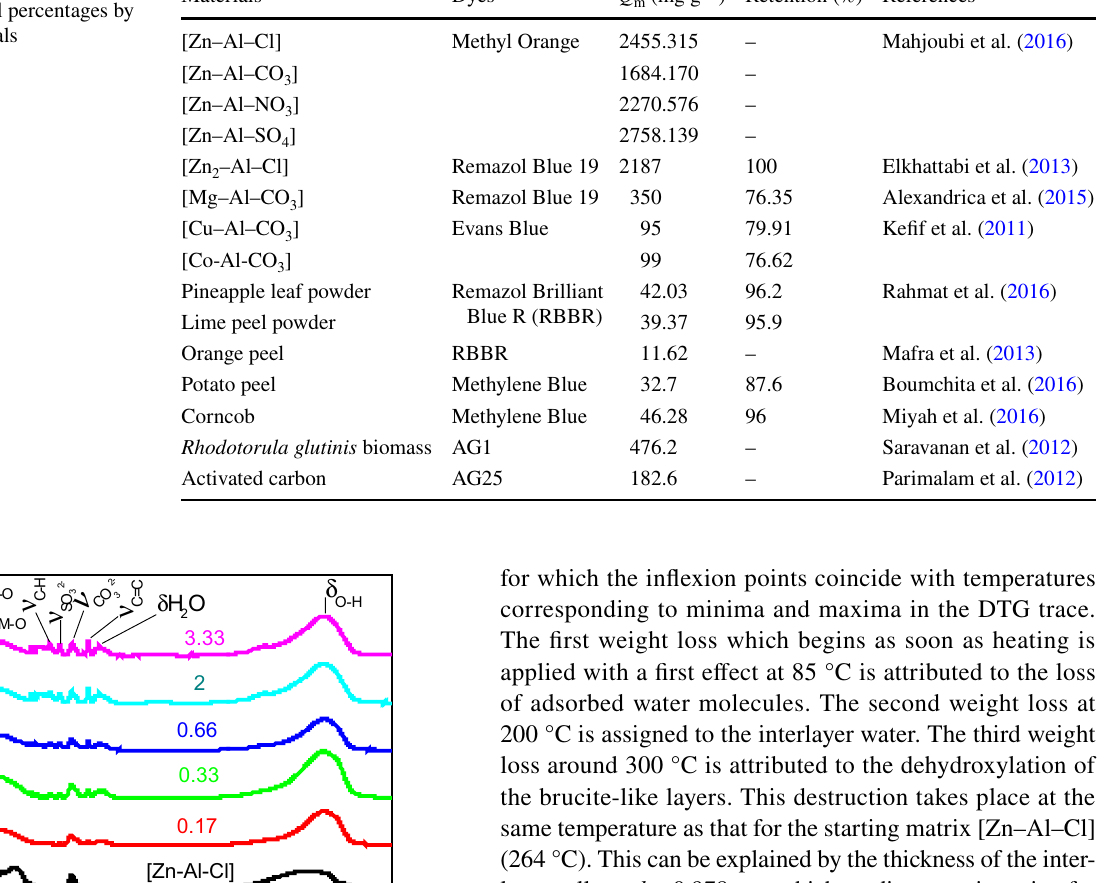
and dye removal percentages by different materials